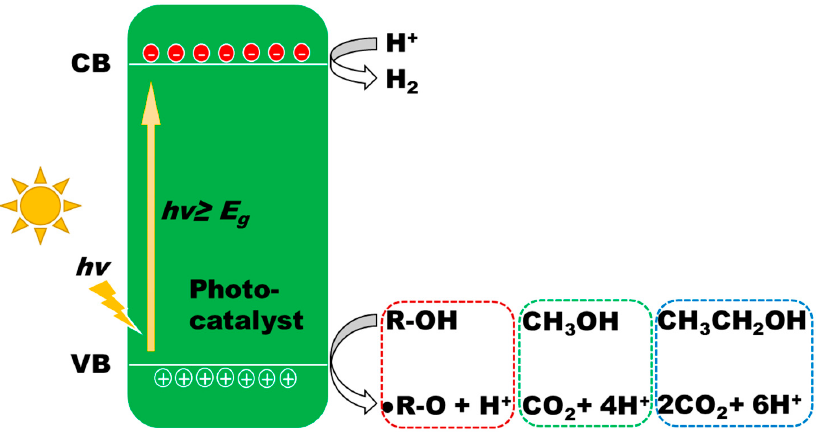
Figure 2. Photocatalytic production of H 2.